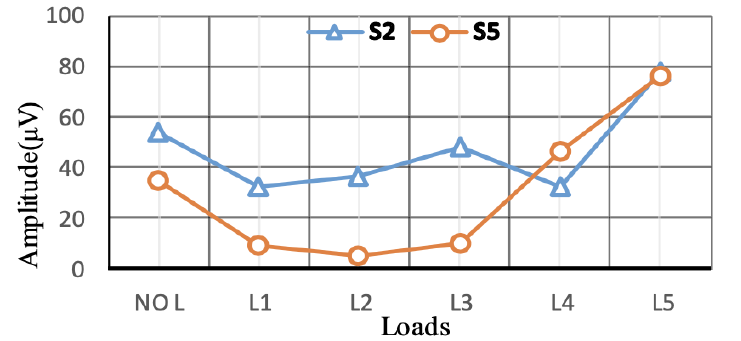
Figure 25. Fault detected